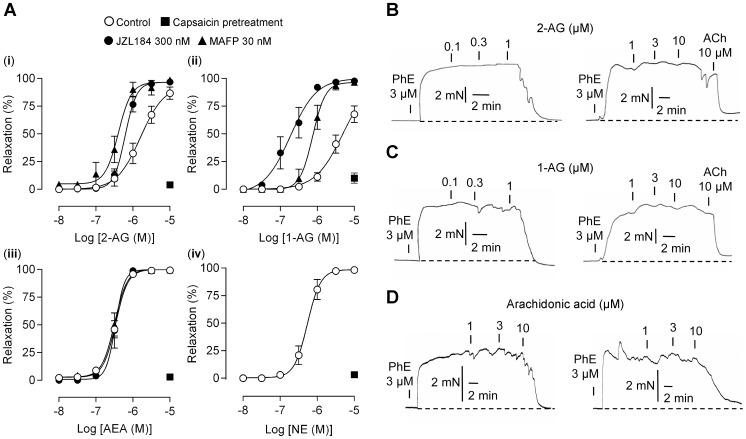
The monoacylglycerol lipase inhibitors MAFP and JZL184 potentiate 2-arachidonoylglycerol and 1-arachidonoylglycerol sensory nerve-mediated vasodilation.(A) Concentration-response curves for (i) 2-arachidonoylglycerol (2-AG), (ii) 1-arachidonoylglycerol (1-AG), and (iii) anandamide (AEA) in the presence of MAFP (n = 6–11), JZL184 (n = 6–8) or vehicle (n = 13–18). The area under the curve was larger in the presence than in the absence of MAFP (P<0.05, 2-AG; P<0.001, 1-AG) or JZL184 (P<0.05, 2-AG; P<0.001, 1-AG). (iv) Concentration-response curves for noladin ether (NE), the stable analog of 2-AG (n = 6–8). The vasodilation evoked by 2-AG, 1-AG, AEA and NE but not arachidonic acid were abolished by capsaicin pretreament (A–D). Traces show vasodilator responses to (B) 2-AG, (C) 1-AG and (D) arachidonic acid after pretreatment with vehicle (left) or capsaicin (right) to cause desensitization and/or neurotransmitter depletion of sensory nerve endings in rat mesenteric arteries. Subsequent application of acetylcholine (ACh) was used to confirm that arteries were able to respond with vasorelaxation (mediated by endothelium-derived hyperpolarising factor; [83]). The capsaicin pretreatment consisted of a 30 min exposure to 10 µM capsaicin followed by washout of capsaicin. The arterial segments were submaximally contracted with phenylephrine (PhE) before addition of the test drugs. The dashed line shows the basal tension level before addition of PhE. MAFP (30 nM) was present in experiments with 2-AG (B) and 1-AG (C). Control experiments were performed in the presence of vehicle (0.1% ethanol). Data are expressed as mean ± s.e.m.